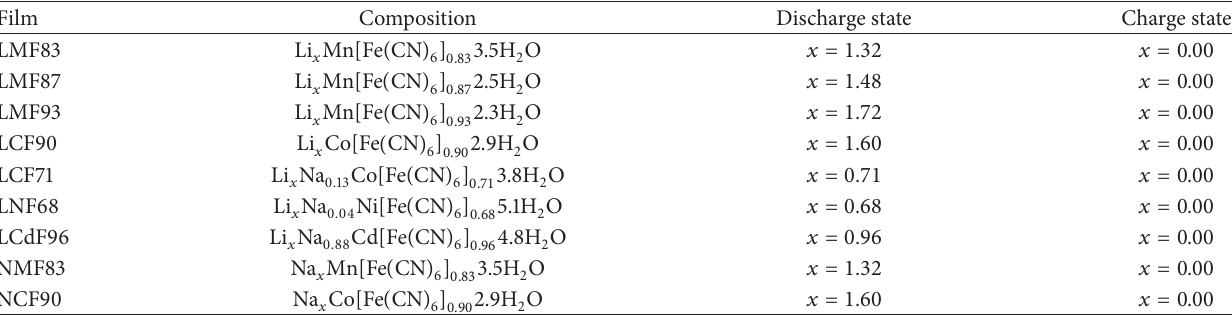
Table 2: Abbreviation, compositions, and Li/Na concentration (𝑥) in discharge and charge